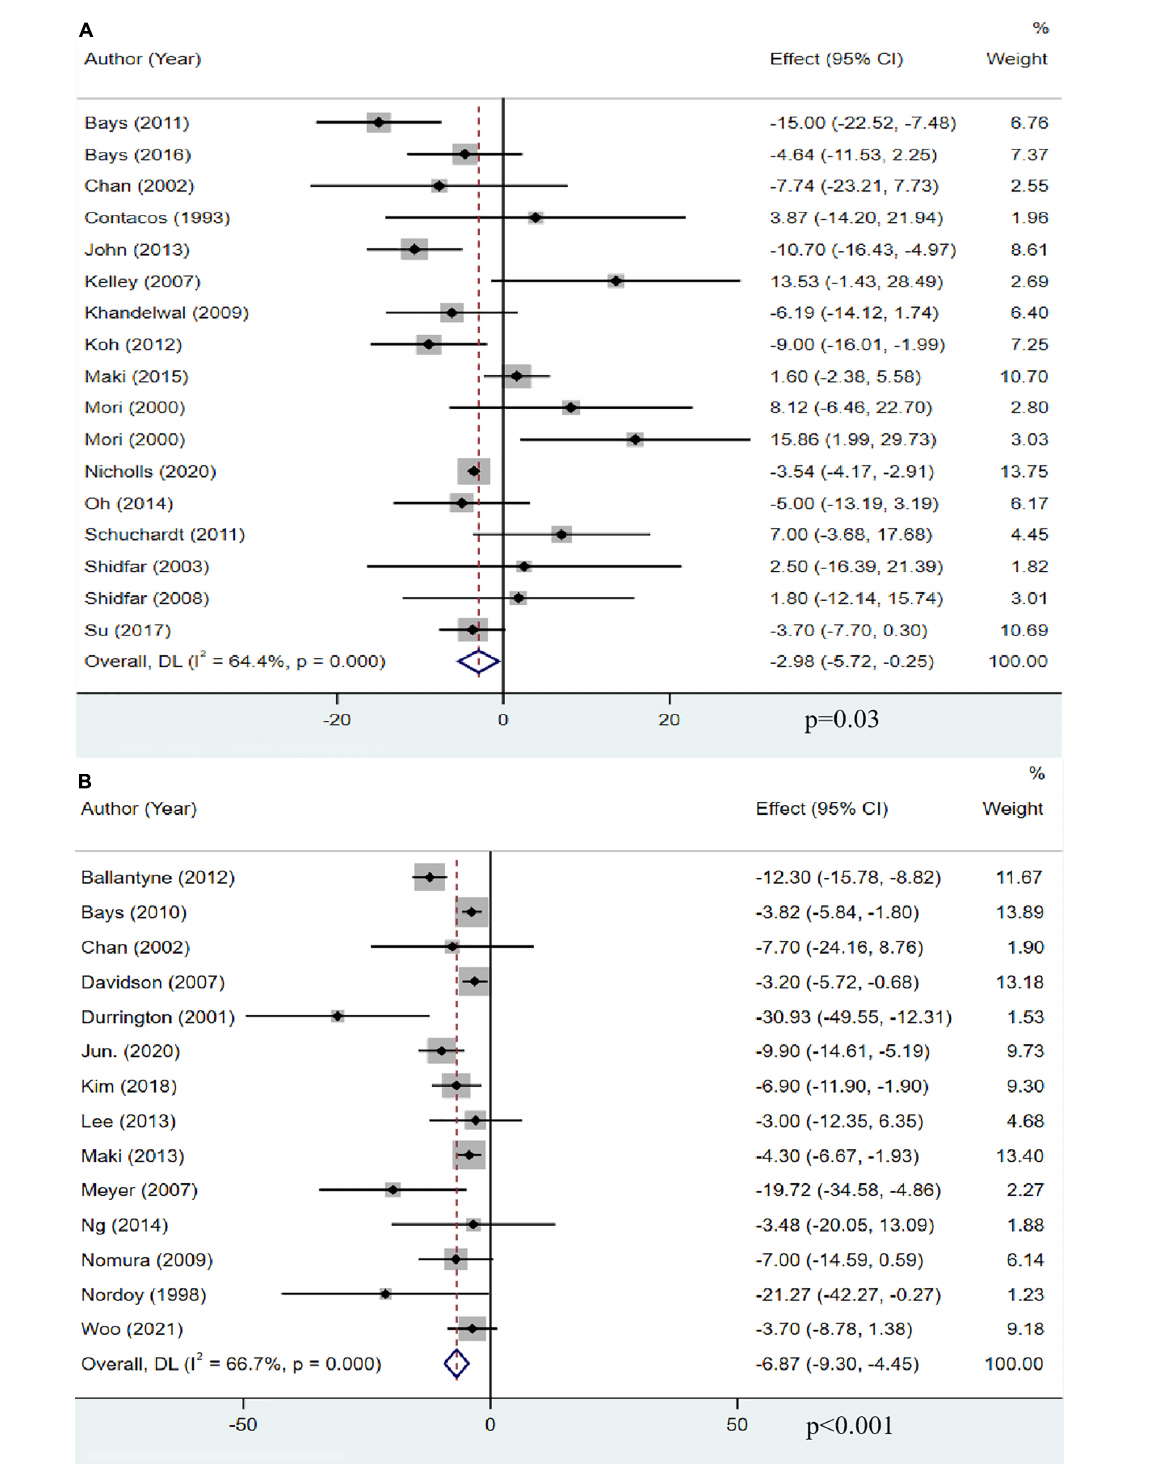
FIGURE4 The effect of OM3-FA on TC. (A) OM3-FA monotherapy; (B) Combined therapy of statins plus OM3-FA.